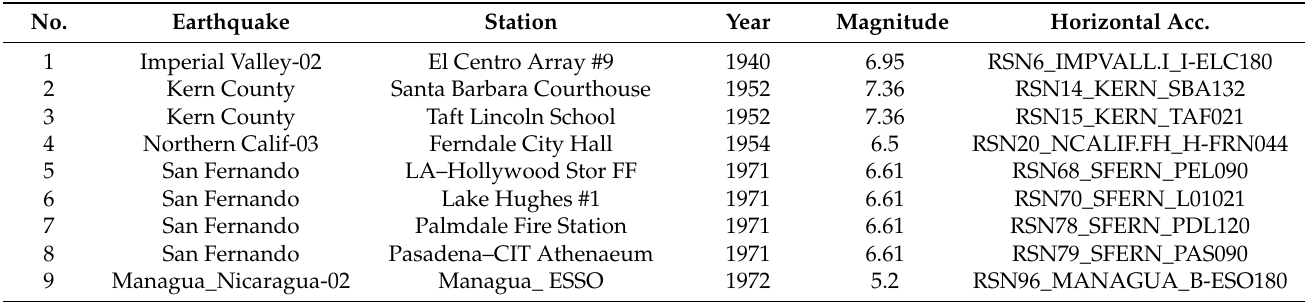
Table 1. Ground motion records characteristics.